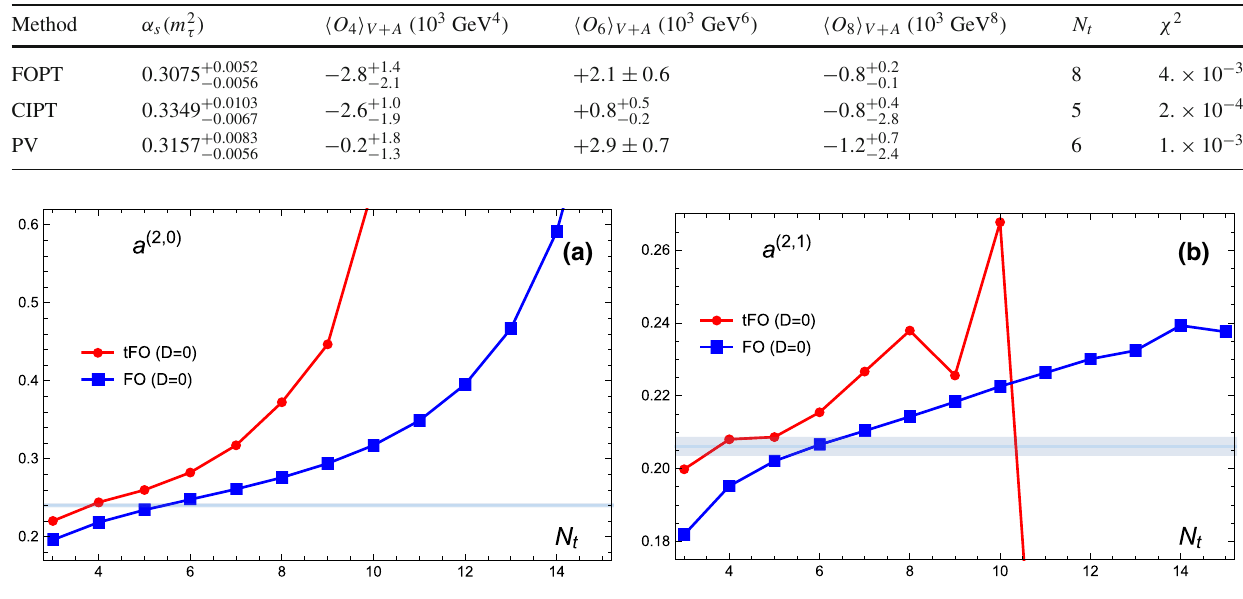
Table 4 The results for α s ( m 2 τ ) and the three condensates (cid:12) O D (cid:13) V + A ( D = 4 , 6 , 8) as obtained by the Borel–Laplace sum rule. Included are the optimal truncation numbers ( N t ) and the values of the fit quality χ 2 [cf. the text and Eq. (57)]